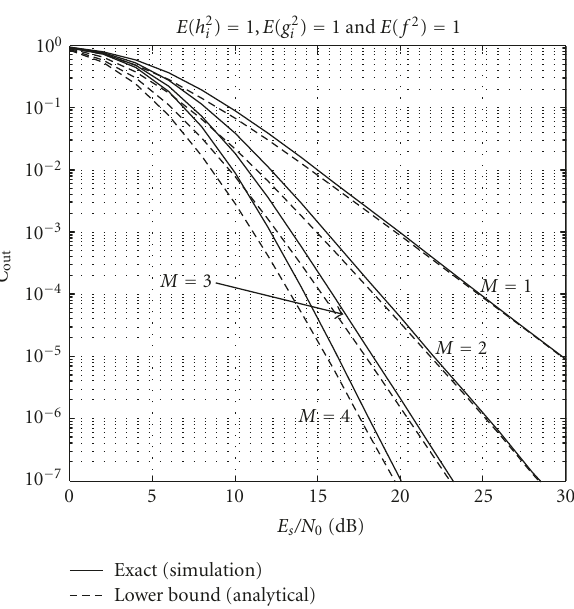
Figure 3: Outage performance for path the best-relay selection scheme over Rayleigh fading